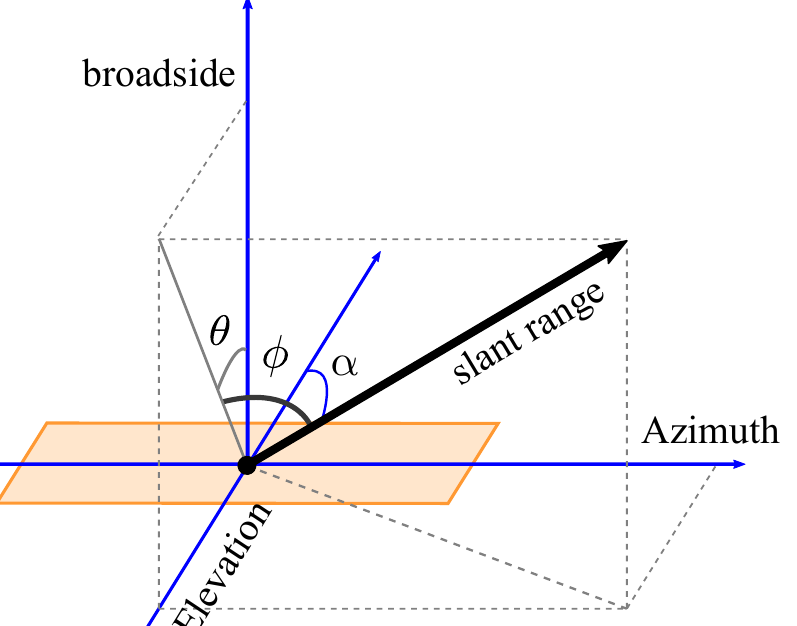
Figure 2. Antenna pattern